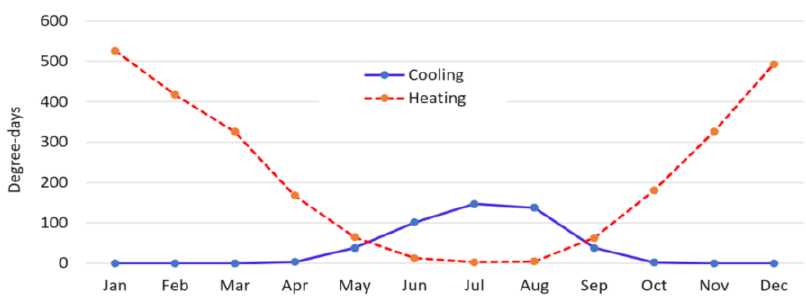
Figure 14. Degree-days of heating/cooling for Dragotin